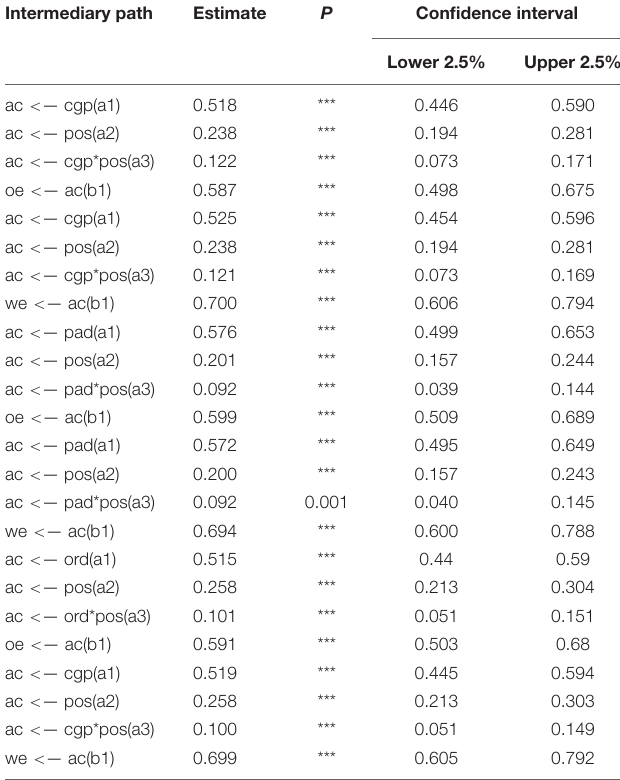
TABLE 2 | Direct effect analysis.